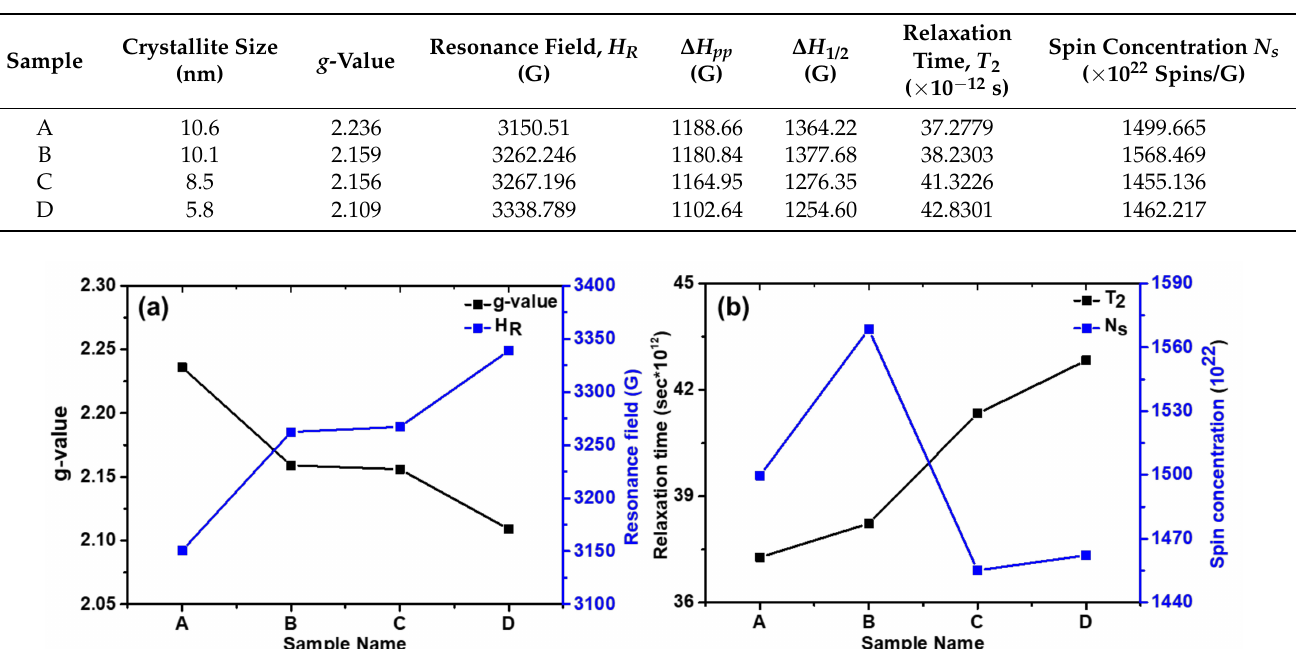
Table 4. Various spin resonance parameters calculated by fitting the FMR spectra of the AMF samples A, B, C, and D.